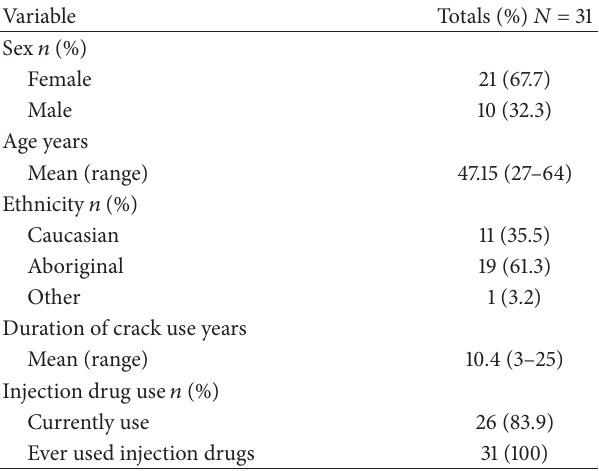
Table 1: Demographic information of study participants ∗